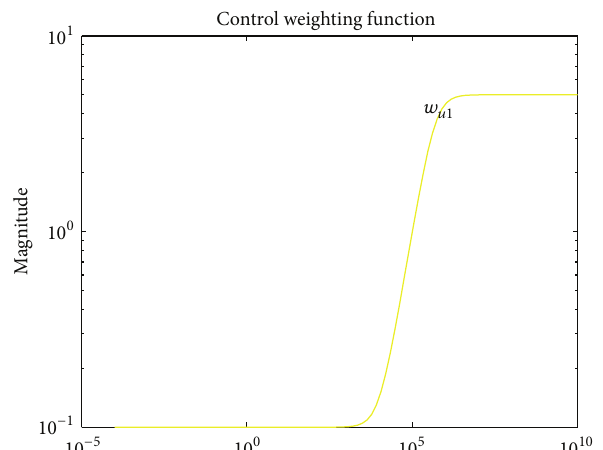
Figure 7: Singular values of 1/𝑤 𝑝 .